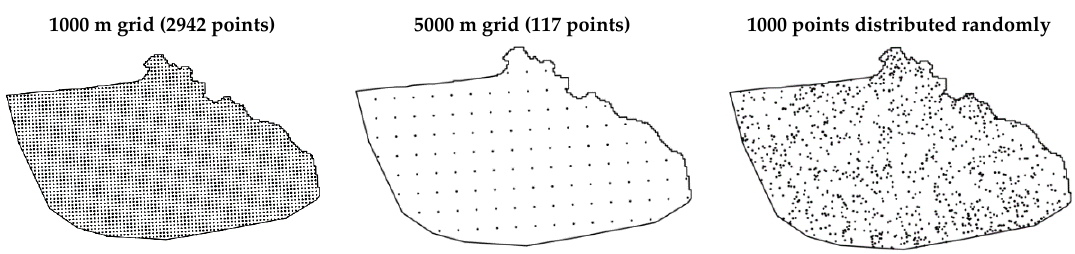
Figure 5. Manner of distribution of control points (analysis of the size of cells).